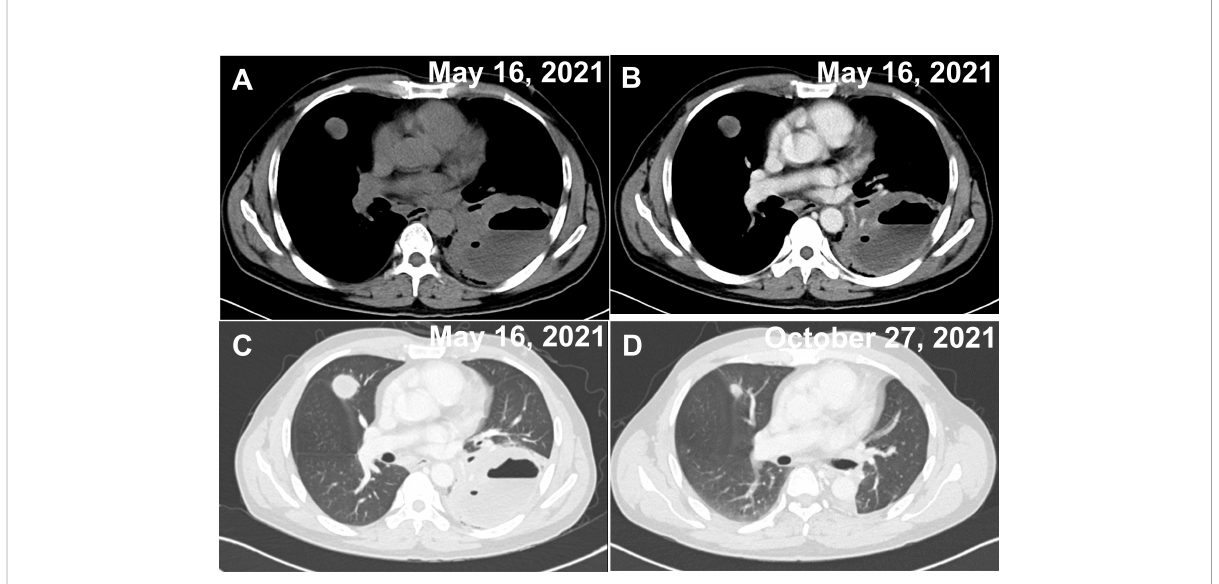
FIGURE 1 Two CT images of the chest on admission and after treatment. (A – C) A cavernous and fl uid- fl at mass in the lower lobe of the left lung and multiple nodules in the upper lobe of both lungs (the largest nodule is shown in the fi gure), both of which show mild circumferential enhancement on enhancement scans. (A) Unenhanced period. (B) Venous phase. (C) Pulmonary window. (D) Postoperative changes in the left lung, with signi fi cantly smaller nodules in the upper lobes of both lungs (largest nodule in the fi gure) than